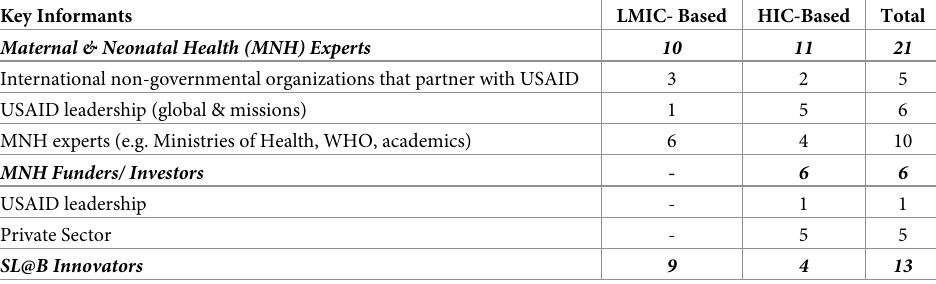
Table 1. Number of key informant perspectives included in the analysis (n =